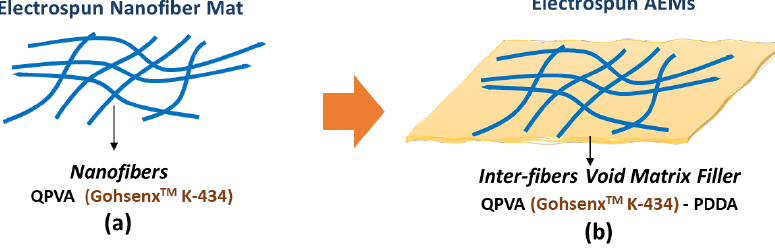
Figure 3. Schematic of ( a ) electrospun nanofiber mat, ( b ) electrospun AEMs.